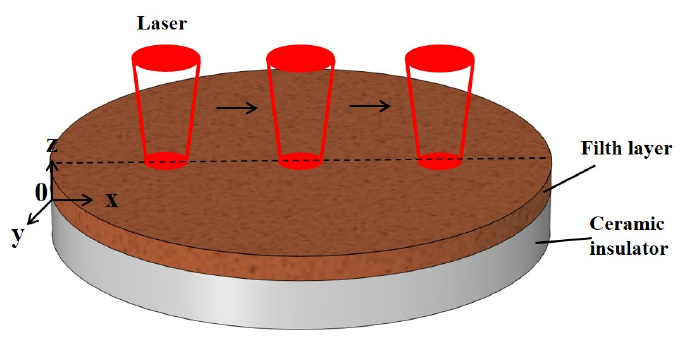
Figure 2. Laser scanning cleaning.